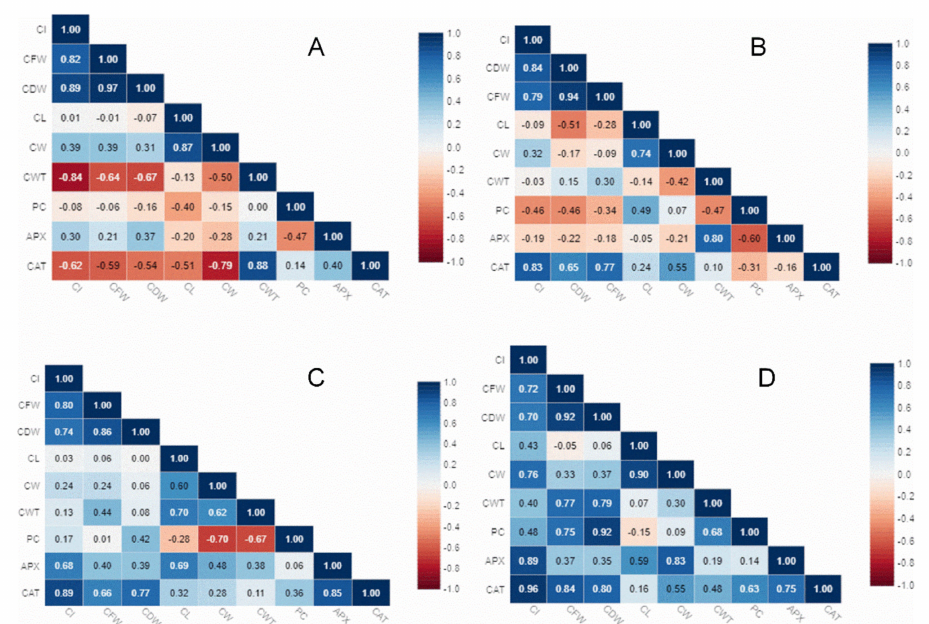
Figure 6. Pearson correlation (r) of nine growth and biochemical characters based on their values in unstressed and stressed conditions. ( A ). T0.00, ( B ). T0.50, ( C ). T1.00, and ( D ).